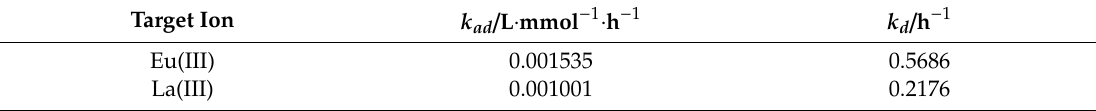
Table 5. Adsorption rate ( k ad ) and desorption rate ( k d ) of Eu(III) and La(III)